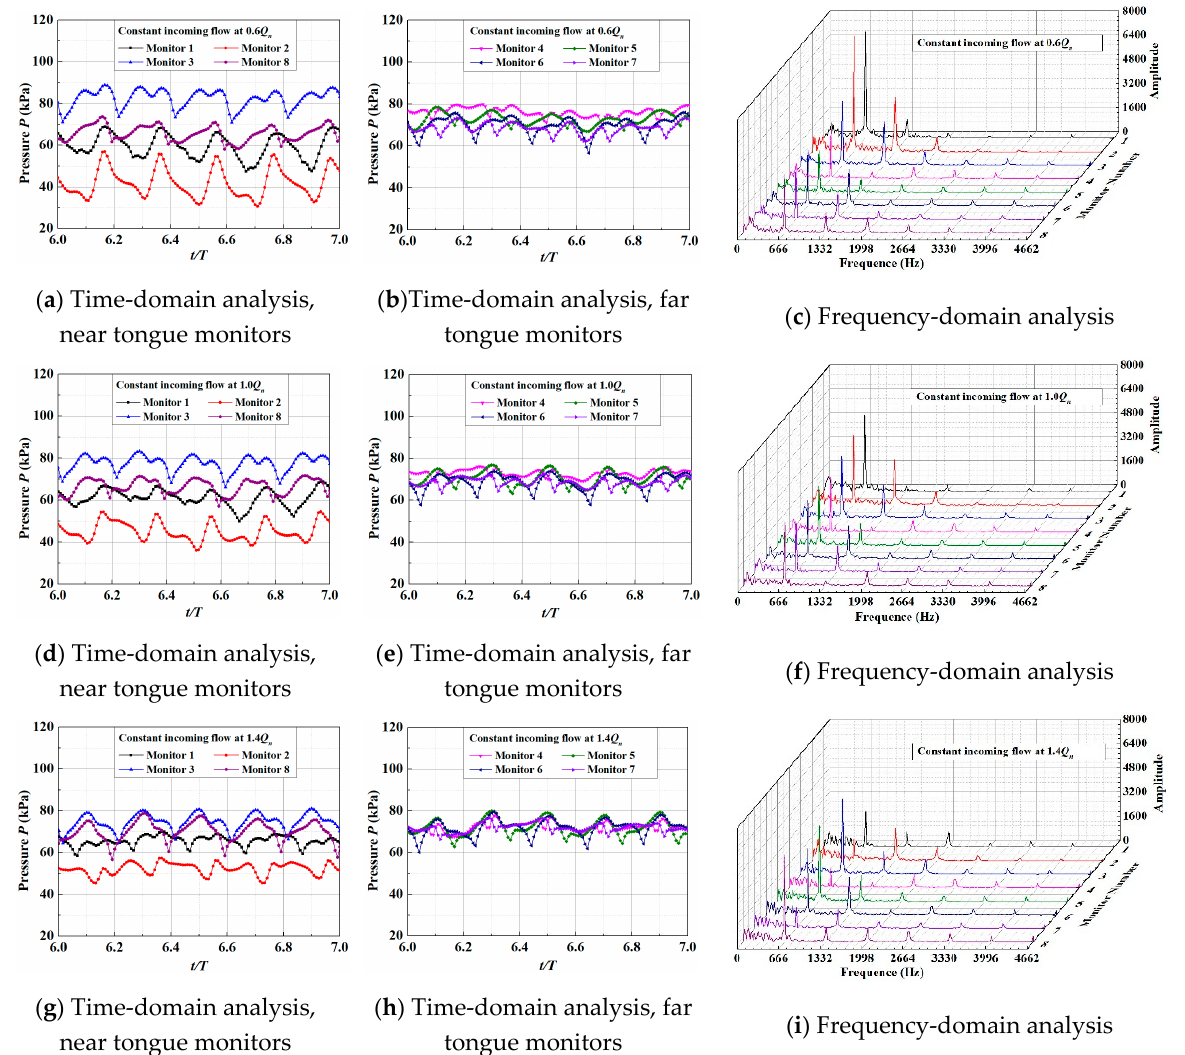
Figure 17. Time-domain and frequency-domain of pressure pulsation under 0.6 Q n (first row), 1.0 Q n (second row) and 1.4 Q n (third row).